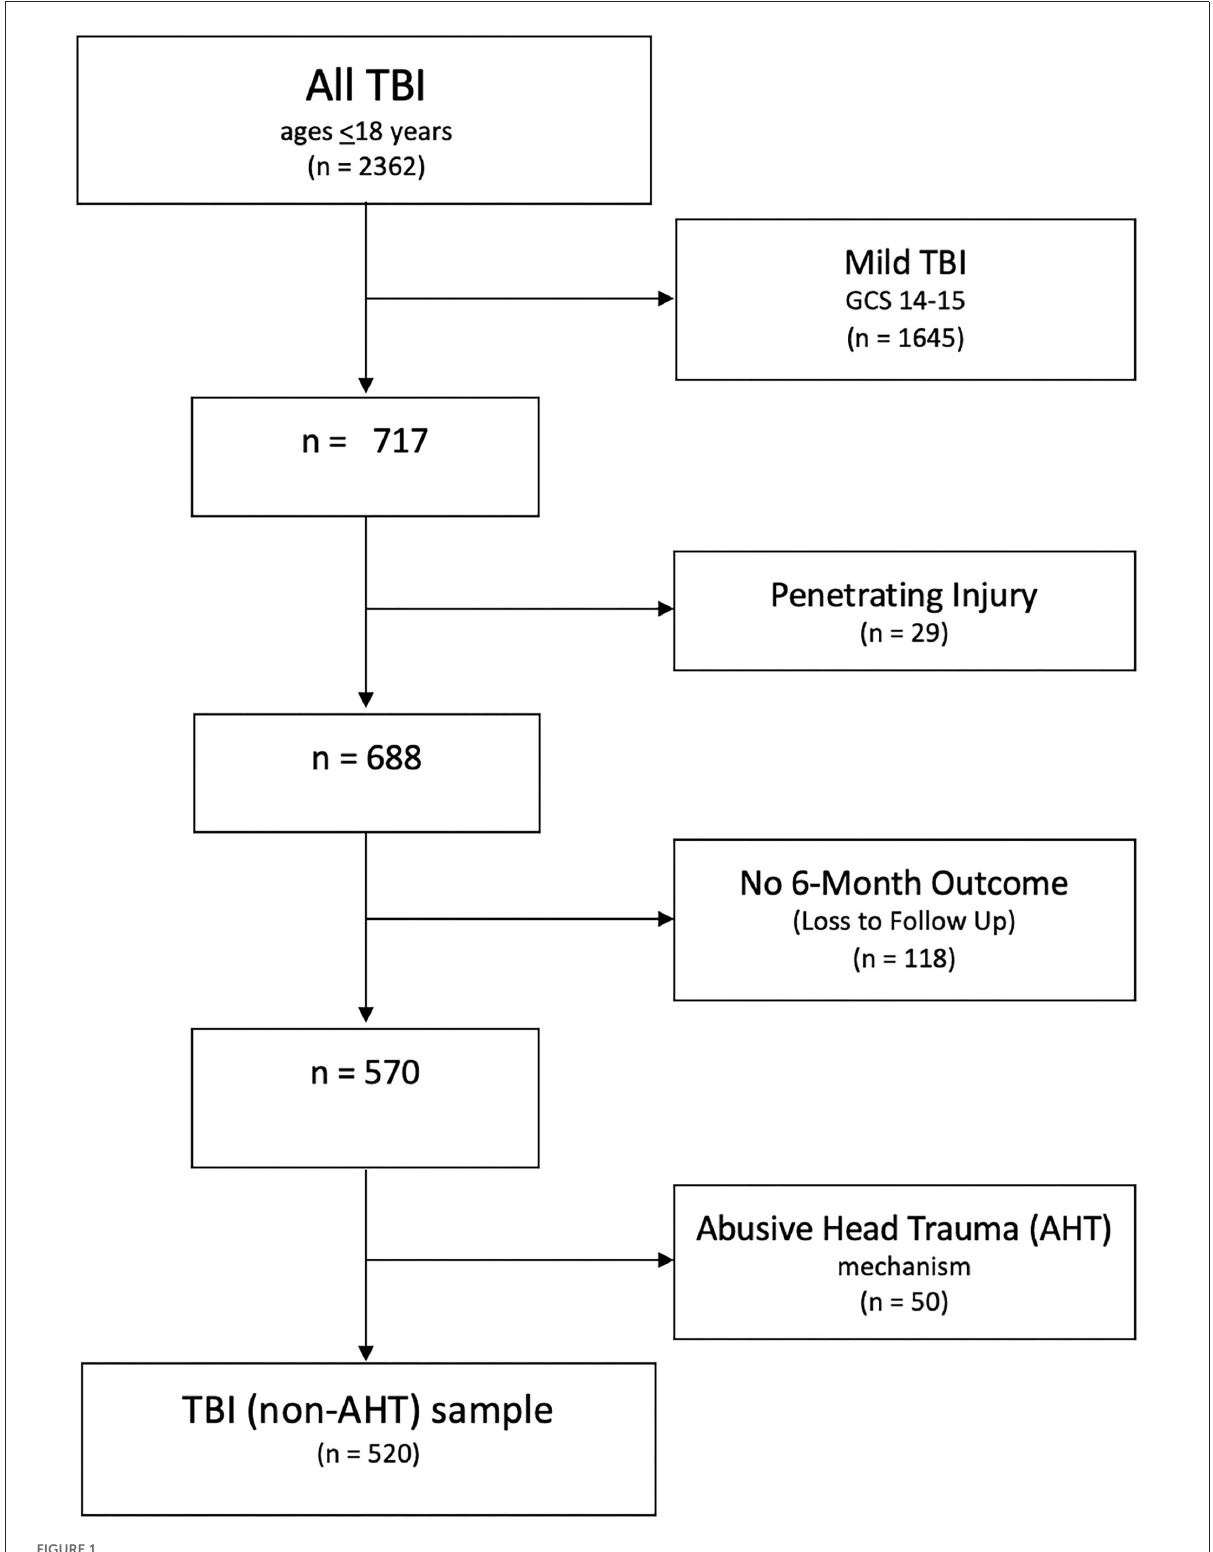
FIGURE1 Inclusion decision